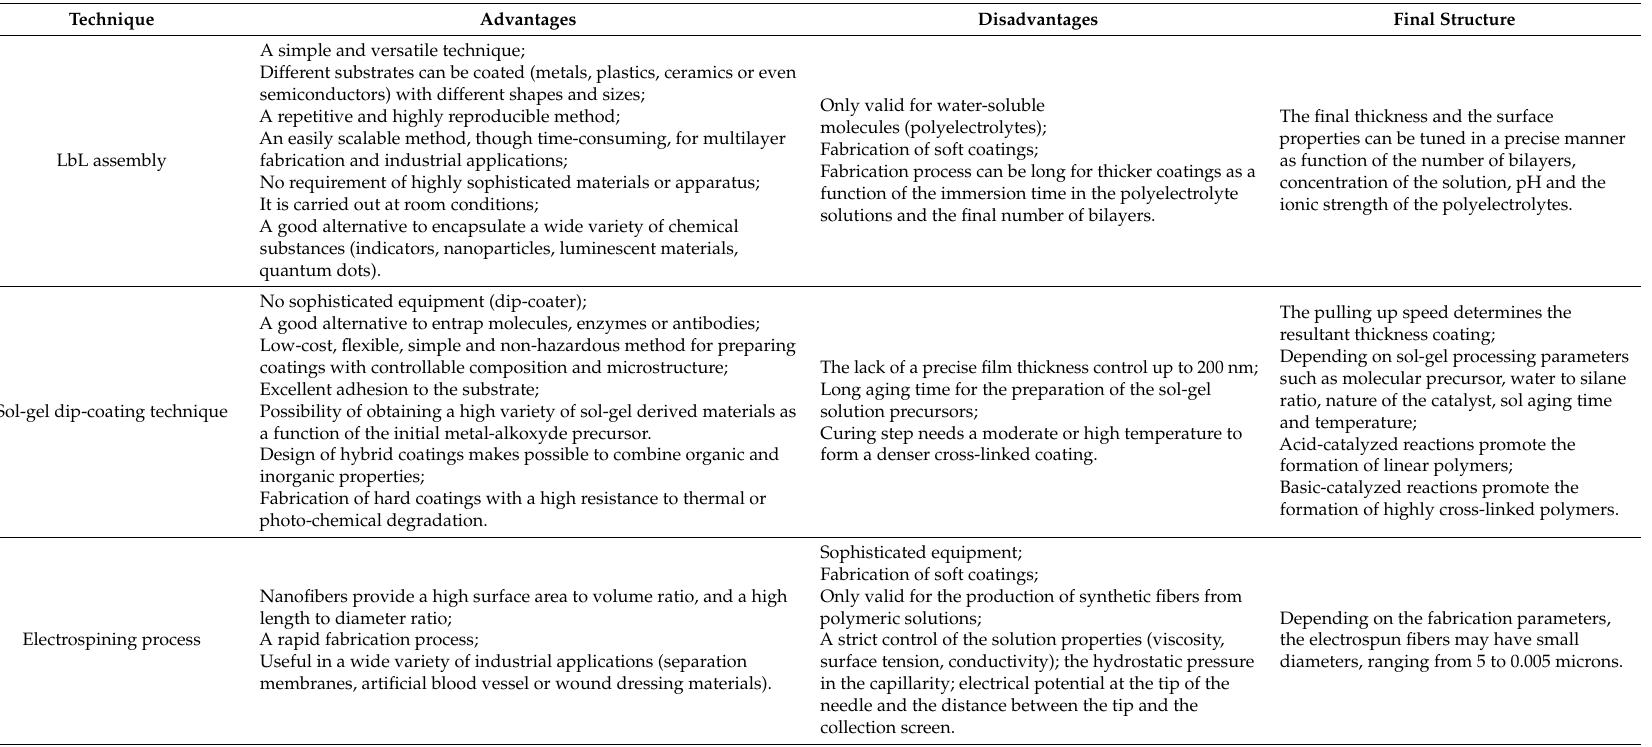
Table 1. Wet-chemical coating techniques evaluated in this work (layer-by-layer assembly, sol-gel dip-coating method and electrospinning process, respectively): advantages, disadvantages and final